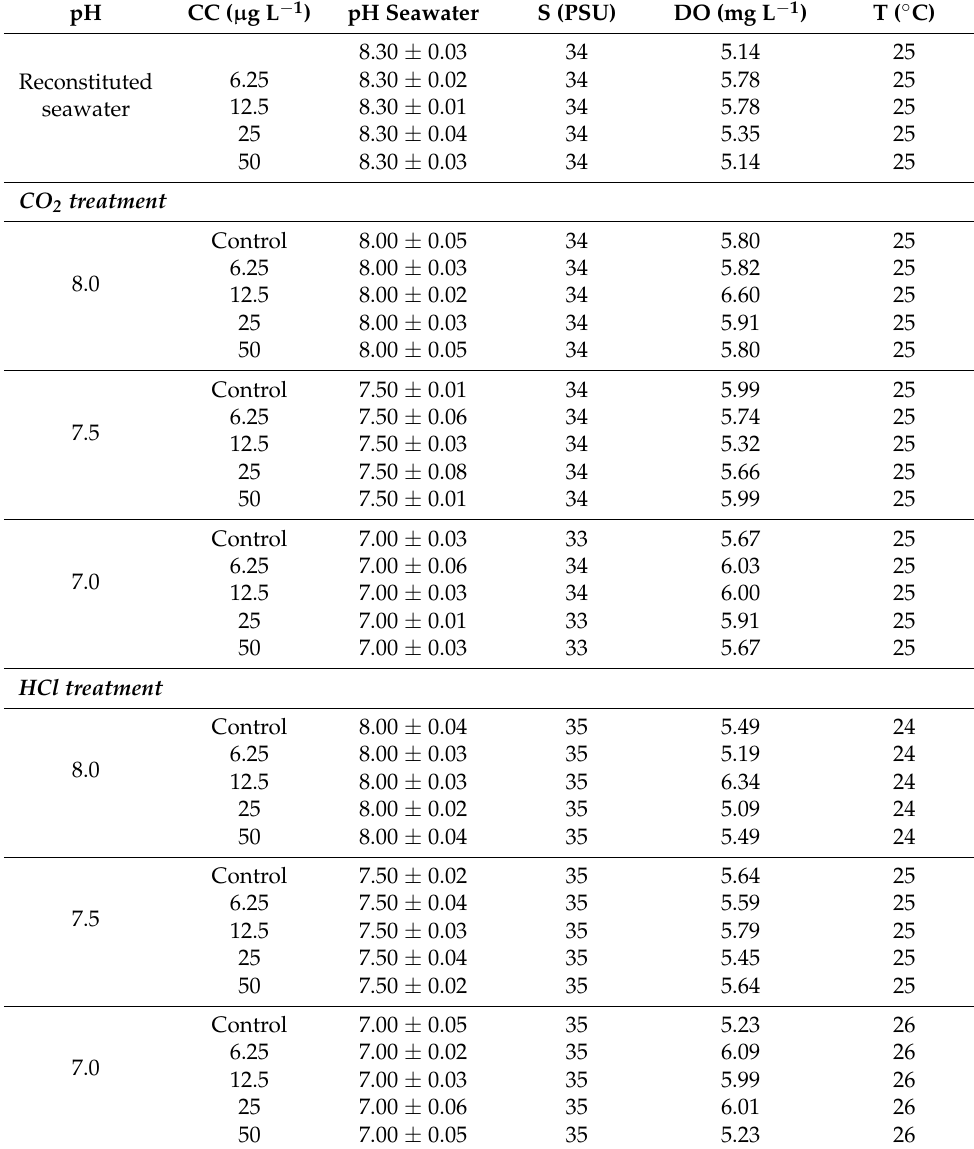
Table 1. Physicochemical water parameters (nominal cocaine–crack CC, pH in seawater, salinity—S, dissolved oxygen—DO, temperature—T) monitored in the different assay treatments (control as reconstituted seawater, CO 2 injection and HCl treatment). pH average ± SD values were calculated from 30 min period measurements taken during a 48 h period.